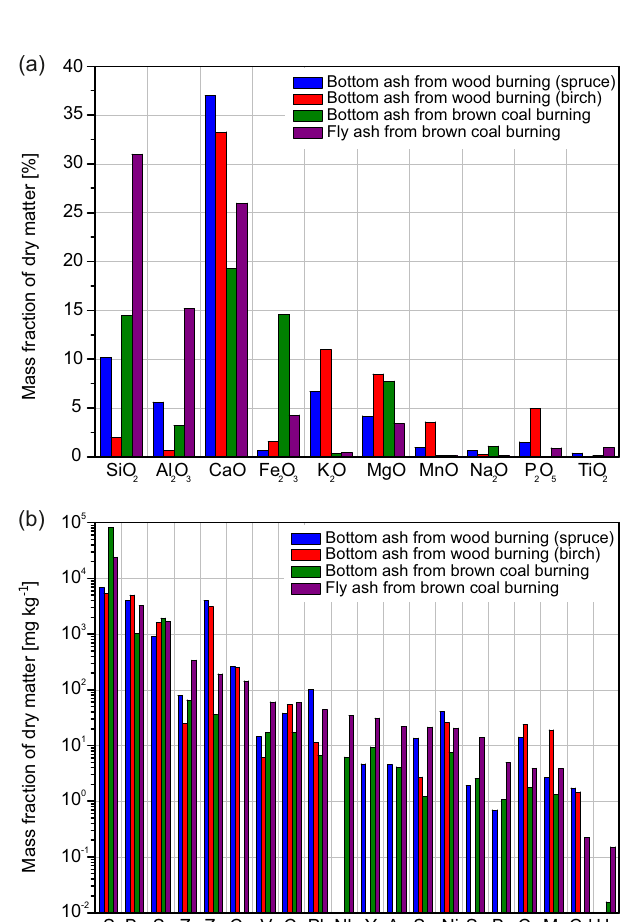
Figure 2. Mass fractions of (a) certain oxides and (b) additional elements in the dry matter of bottom ash from spruce, birch, and brown coal burning, as well as fly ash from brown coal burning. The analysis was performed by means of inductively coupled plasma- sector field mass spectrometry (ICP-SFMS) at ALS Scandinavia AB (Luleå, Sweden). Table 3 shows the values given in the bar chart and the associated